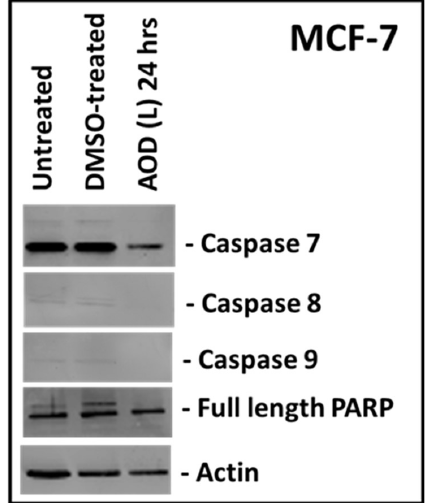
Figure 5. Western blot analysis of MCF-7 cells treated with A. orientalis dichloromethane leaf fraction (AOD (L)) at 250 µg/mL and tested for the activation of caspases 7, 8 and 9, and poly ADB ribose polymerase (PARP). Actin antibody was used as a loading control. DMSO-treated, DMSO control having the same amount of DMSO as the test sample.